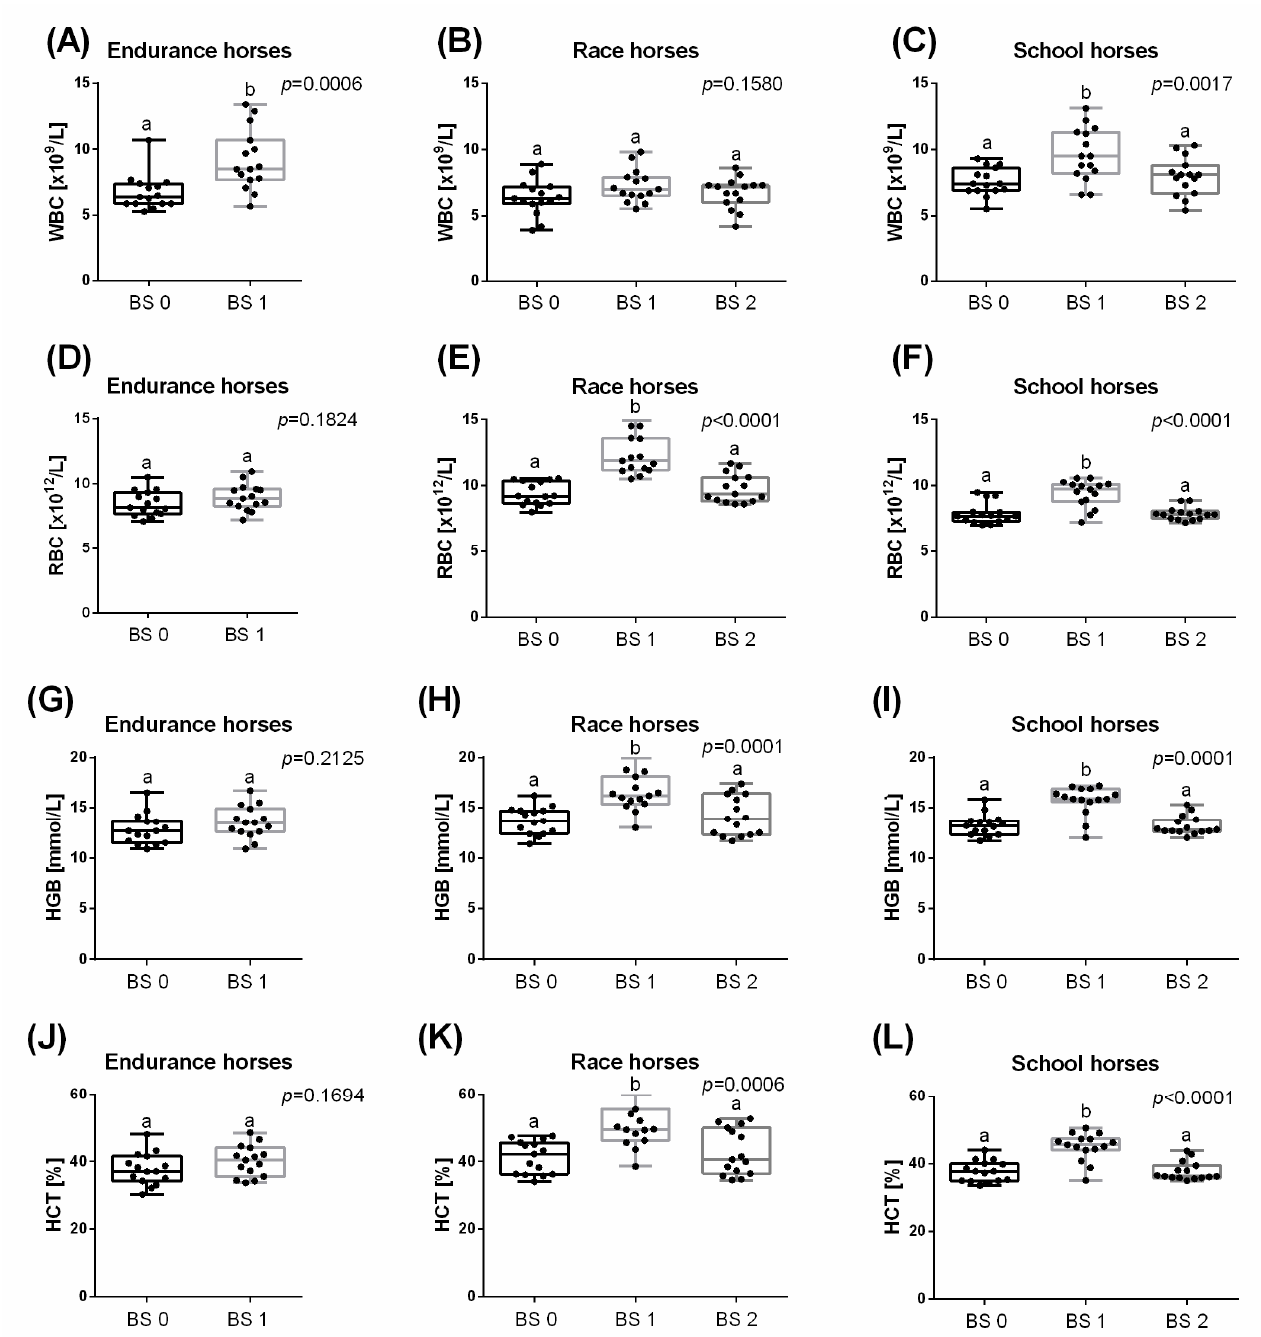
Figure 1. Selected hematological parameters (mean + SD), white blood cell count (WBC) ( A – C ); red blood cell count (RBC); ( D – F ); hemoglobin concentration (HGB); ( G – I ); hematocrit (HCT); ( J – L ) measured before training (BS 0; individual values marked with dots), immediately after training (BS 1; individual values marked with squares) and 30 min after training (BS 2; individual values marked with triangles) in endurance horses ( A , D , G , J ), race horses ( B , E , H , K ) and school horses ( C , F , I , L ). Lower case letters indicate differences between BSs for p < 0.05.